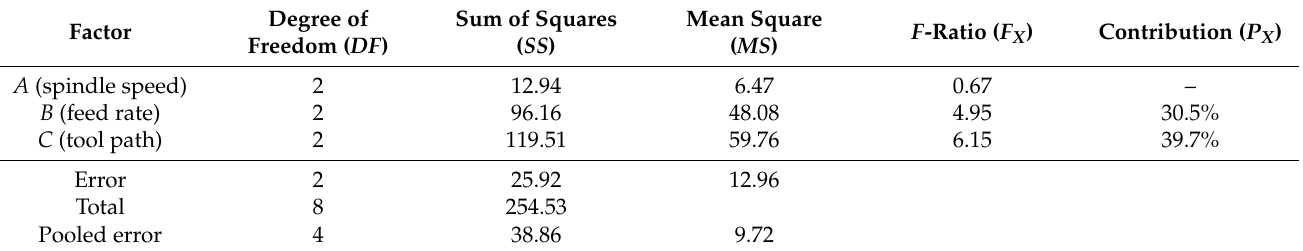
Table 12. ANOVA for the profile